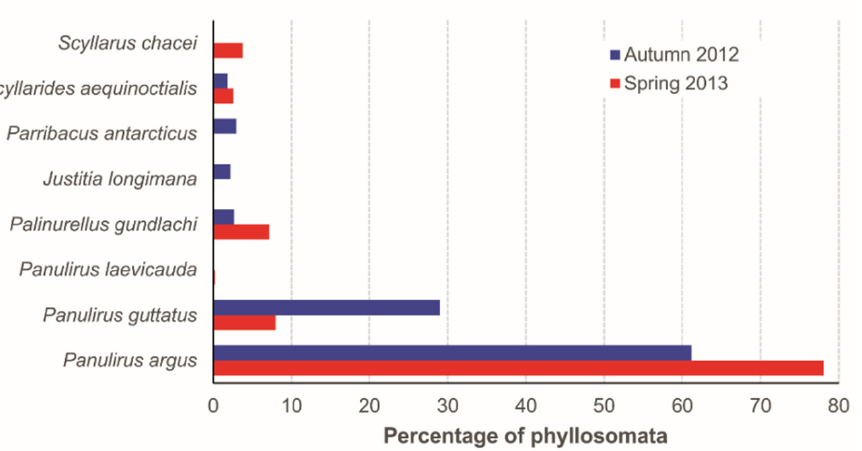
Figure 3. Percentage of phyllosomata (all stages) per species collected in the autumn 2012 cruise (N = 1715) and the spring 2013 cruise (N = 849).